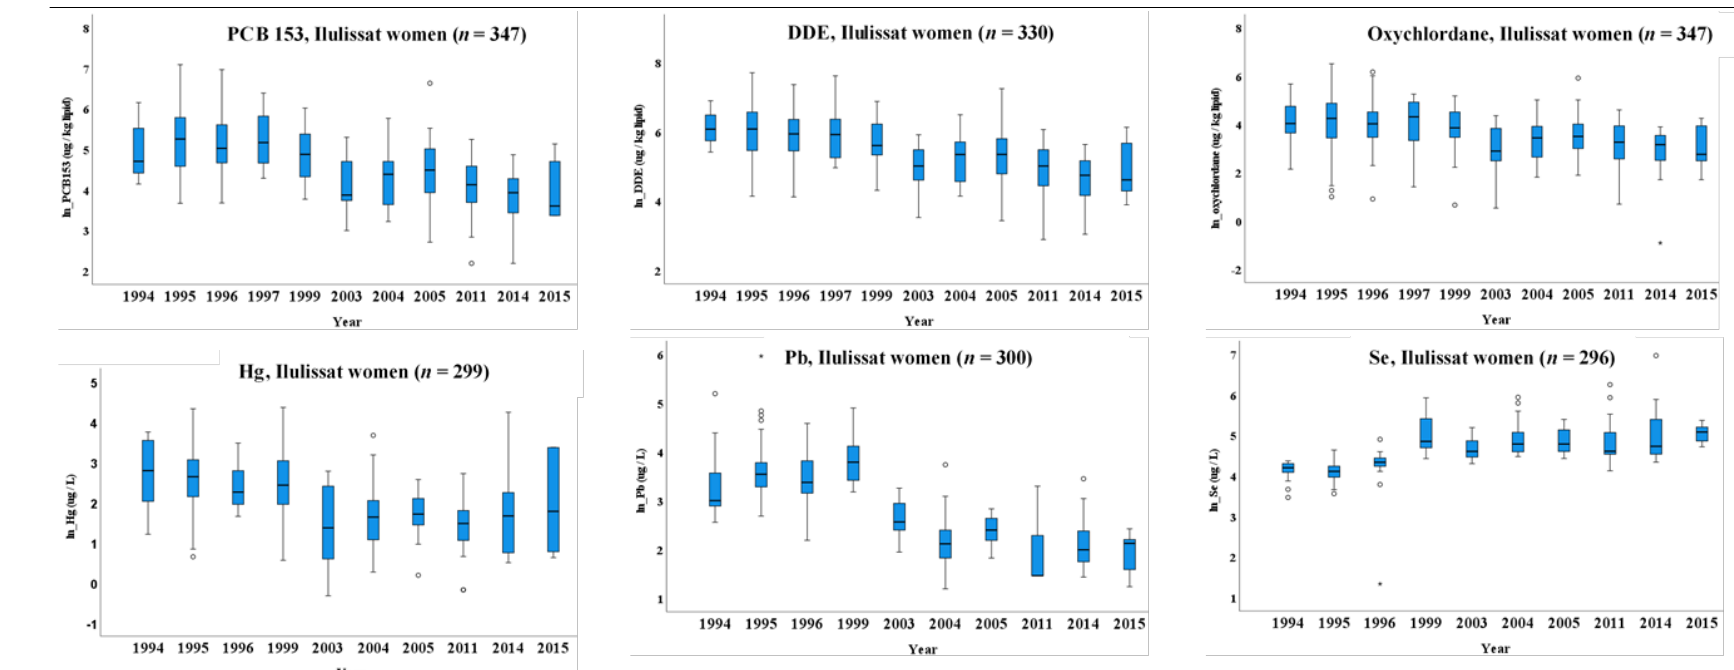
Figure 3. Time trend of lipPOPs and metals in Ilulissat women during 1994–2015. The boxes display the 25th and 75th centiles, and the line inside the boxes represents the median value. The whiskers display the lower and upper values within 1.5 times the interquartile range beyond the box. Outliers are marked with dots. The data are raw data and in ln-transformed scale. The figure in normal scale is given as Figure S2. Please see Table 2 for the adjusted data. LipPOP: legacy lipophilic POPs; for single POP congeners and metals, see abbreviation list.